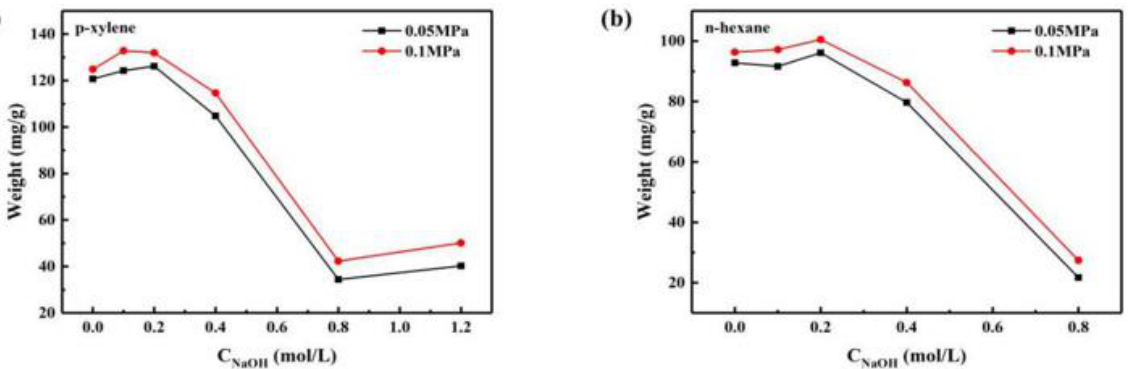
Figure 8. Variation in the adsorption capacities for ( a ) p-xylene and ( b ) n-hexane of samples subjected to alkali after H 2 C 2 O 4 treatment.